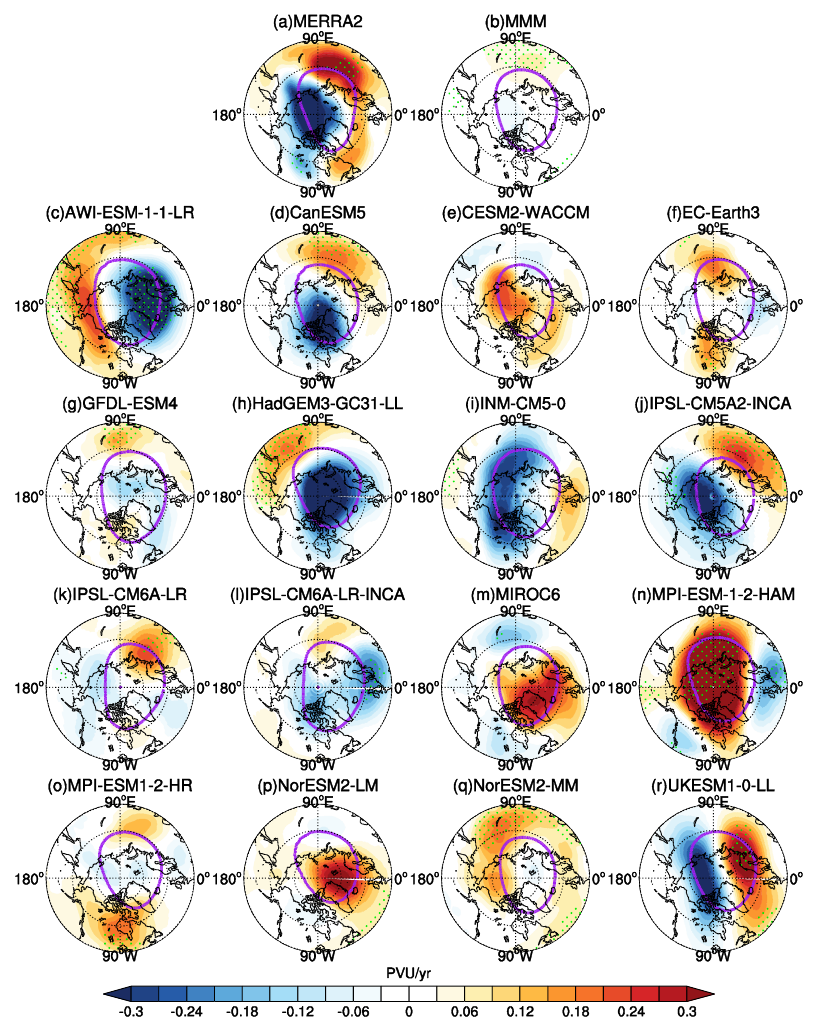
Figure 8. Climatological mean of polar vortex edge (purple contour) and linear trend of PV aver- aged between 430–600 K (shaded) for the period 1981–2014 in February derived from ( a ) MERRA2, ( b ) multi-model mean and ( c – r ) each CMIP6 model.